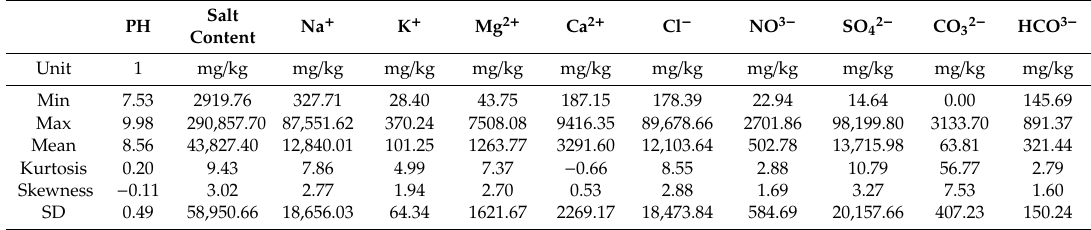
Table 2. Descriptive statistics of the